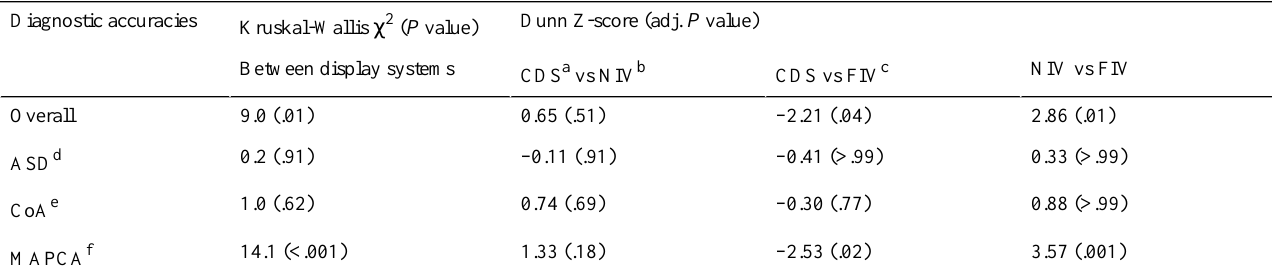
Table 6. Kruskal-Wallis and Dunn test results on the overall congenital heart disease cases and broken down by type between the display systems on diagnostic